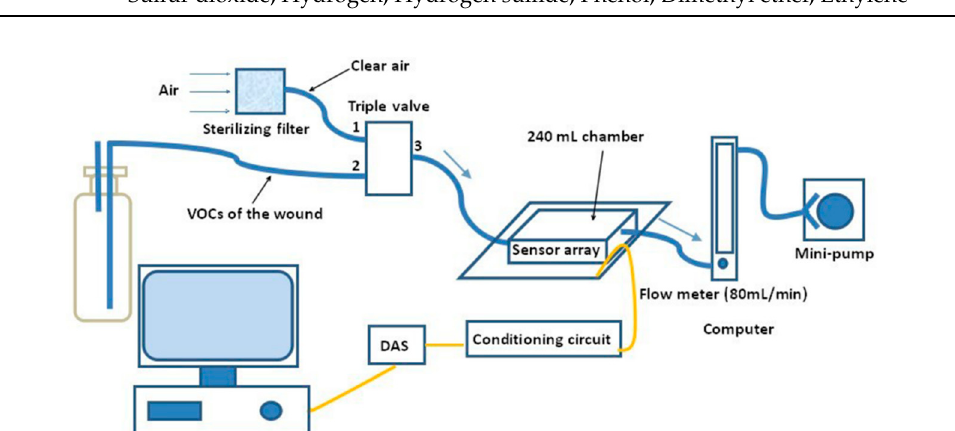
Figure 3. Schematic diagram of the experimental system.